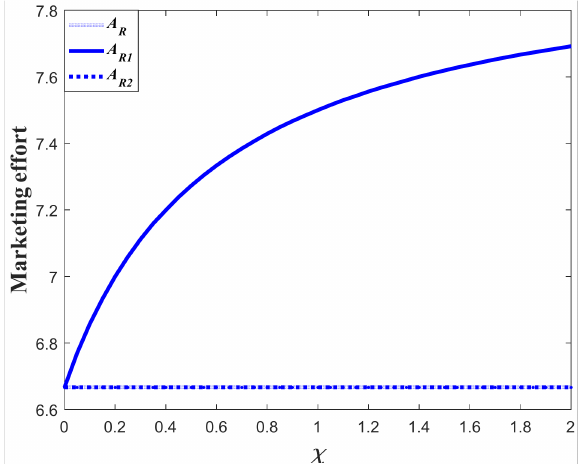
Figure 12. Marketing effort before and after the event (Scenario 1).